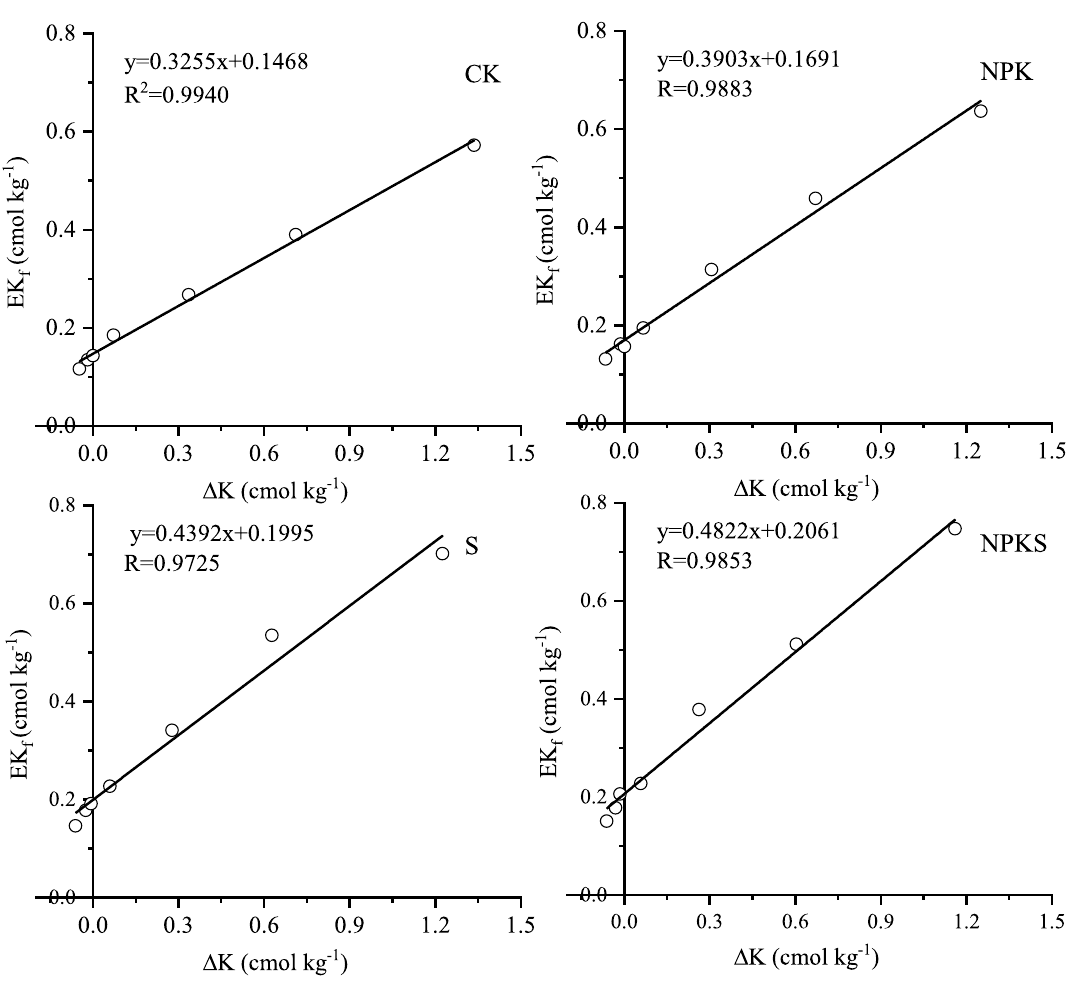
Figure 4. Plots of EK f versus ∆K for tested soils with or without straw return. (CK, no fertilization; NPK, mineral fertilizing; S, straw 6000 kg h m −2 ; NPKS, NPK with straw 6000 kg h m −2 ; EK f , NH 4 OAc extractable K determined after equilibration period; ΔK, amount of total K adsorbed or release from soil during